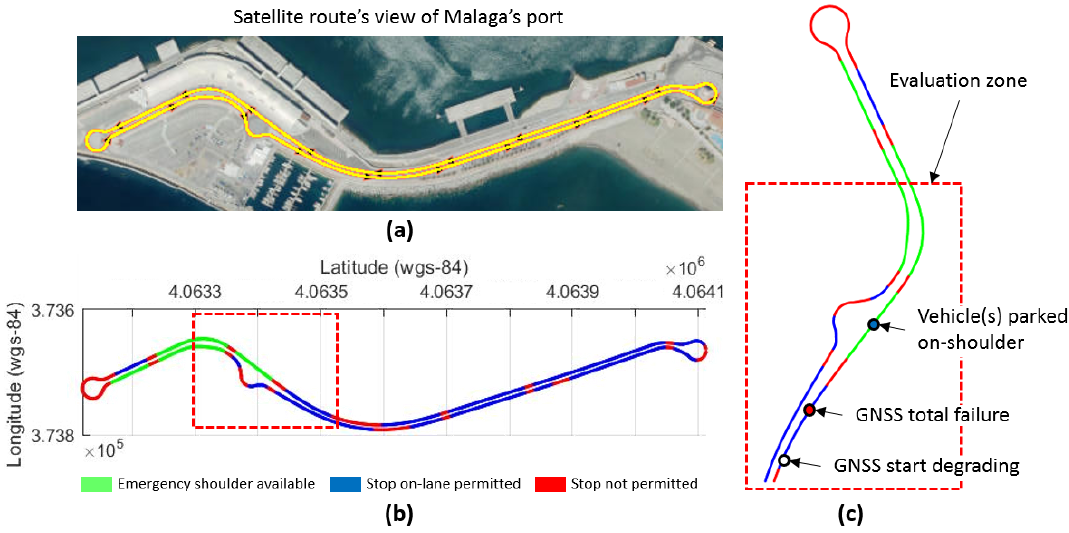
Figure 6. Realistic environment scenario for automated driving system tests on simulation. ( a ) Satellite’s view of urban route, ( b ) permitted and non-permitted stops in case of total positioning failure, and ( c ) evaluation zone for test case